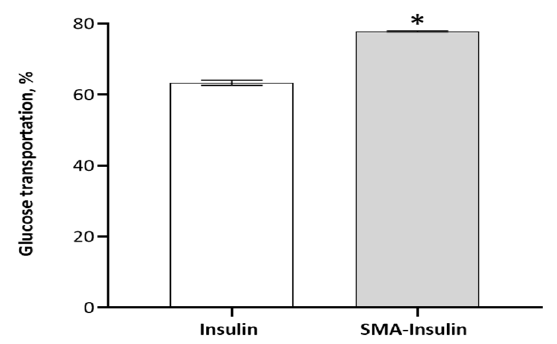
Figure 3. Glucose uptake of insulin and SMA-insulin micelles. HepG-2 cells were starved in DMEM without serum overnight, followed by 40 min of incubation in KRPH buffer. Then, HepG-2 cells were treated with SMA-insulin and free insulin (100 μ M), simultaneously to the addition of 2-DG (10 mM) to the media. The 2-DG uptake was assessed over 1 h. The accumulation of fluorometric end-product generation of 2-DG was measured using λ ex = 535/ λ em = 587 nm. Data are expressed as the mean ± SEM ( n = 4). * indicates a statistical difference from the insulin group, p < 0.05.